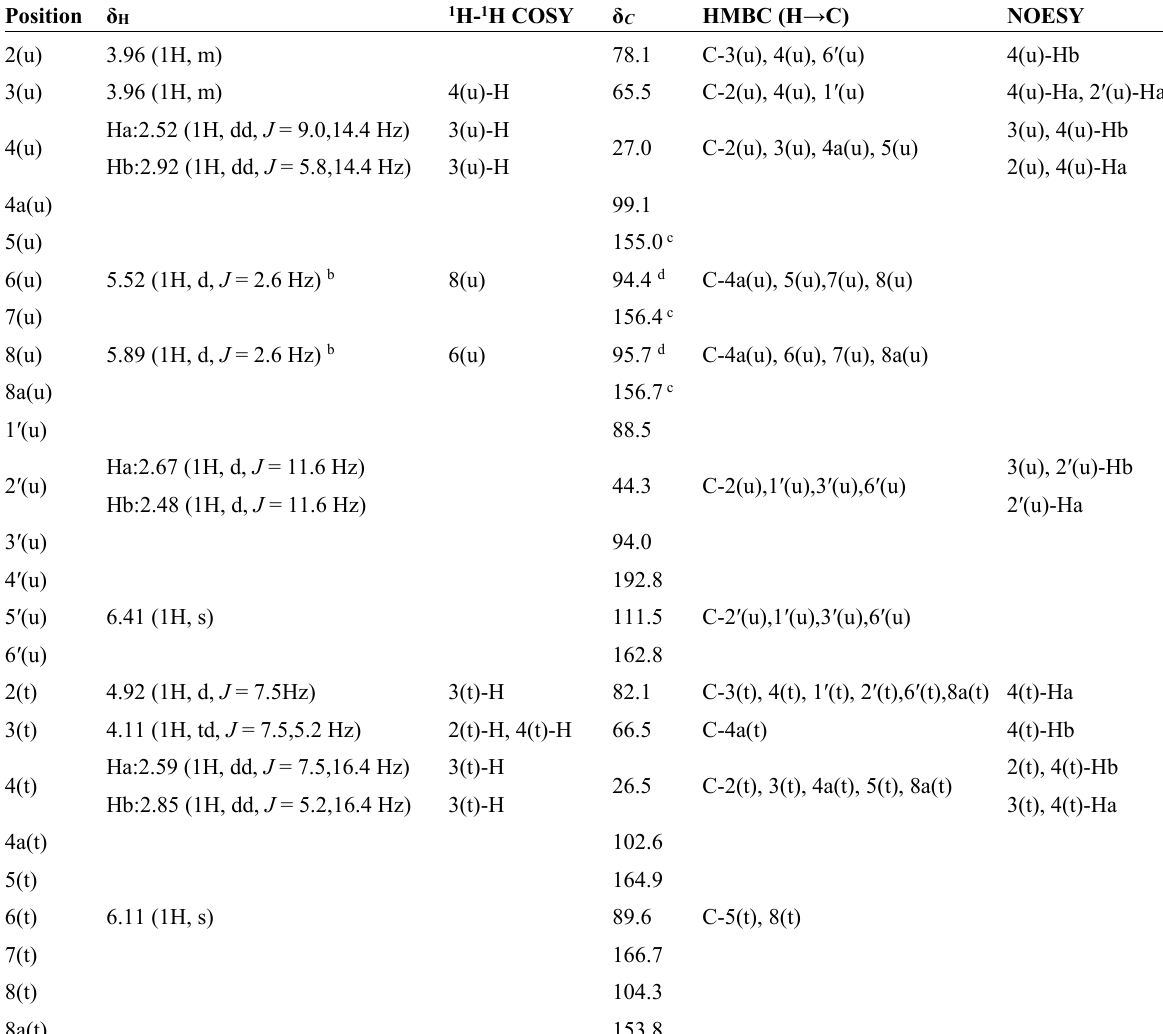
Table 2. 400 MHz 1 H-NMR and 100 MHz 13 C-NMR data of 10 in CD 3 OD a